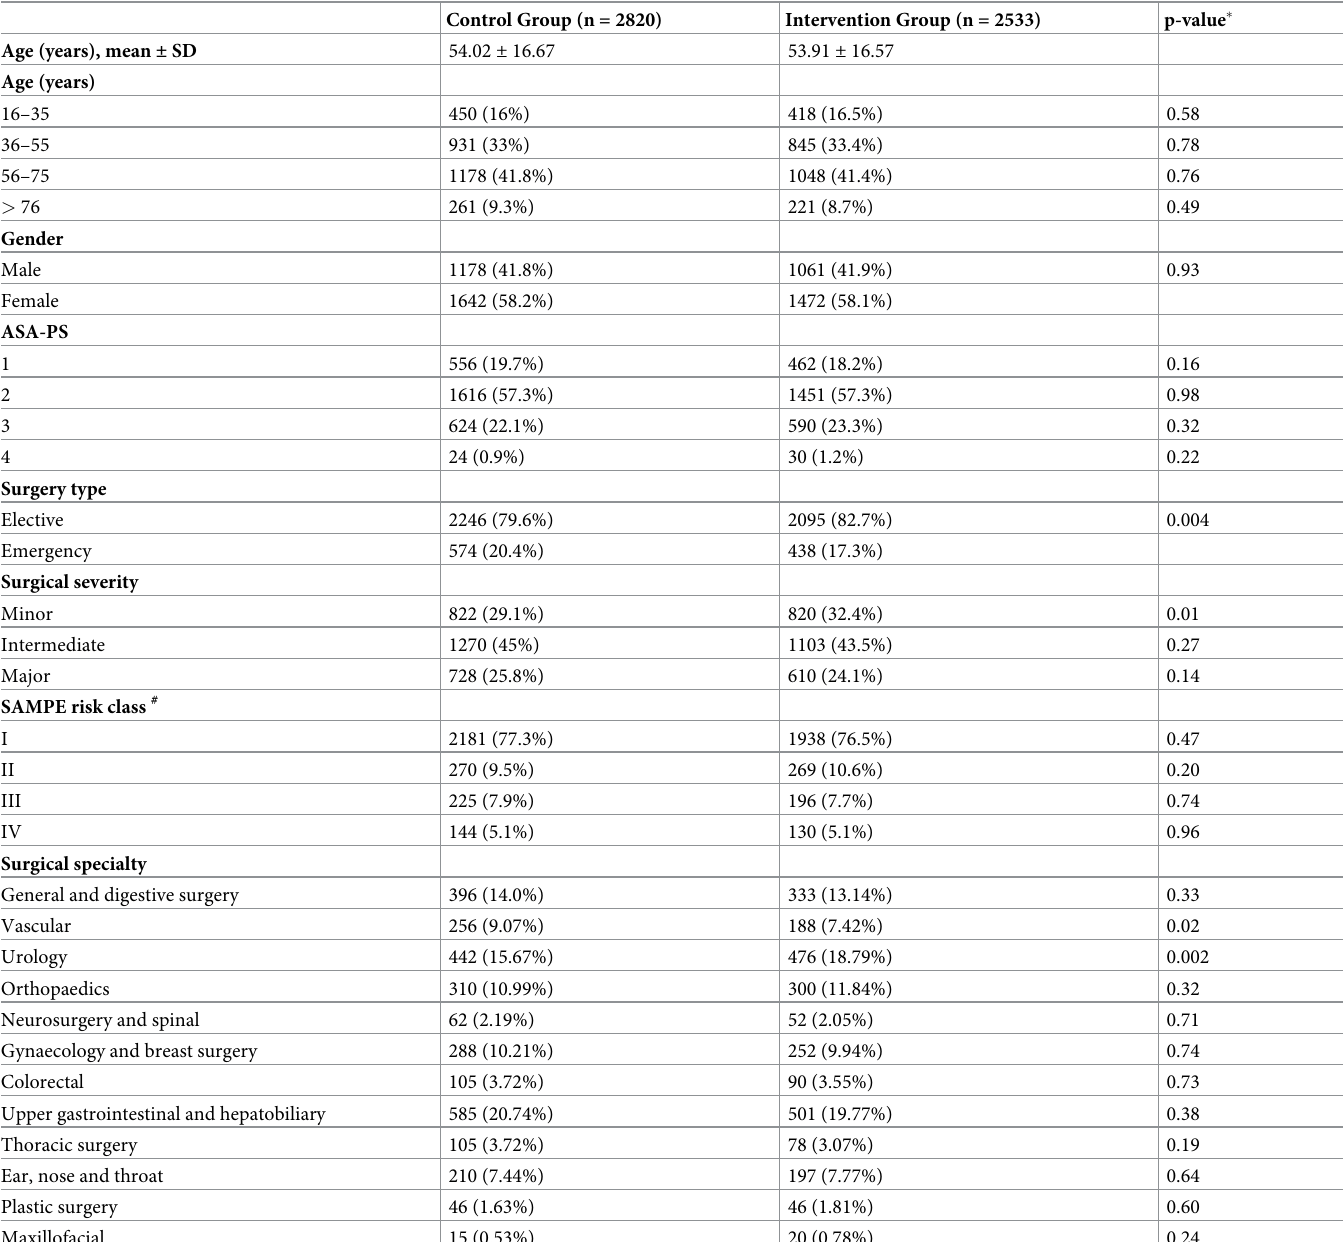
Table 1. Characteristics of Group 1 (control) and Group 2